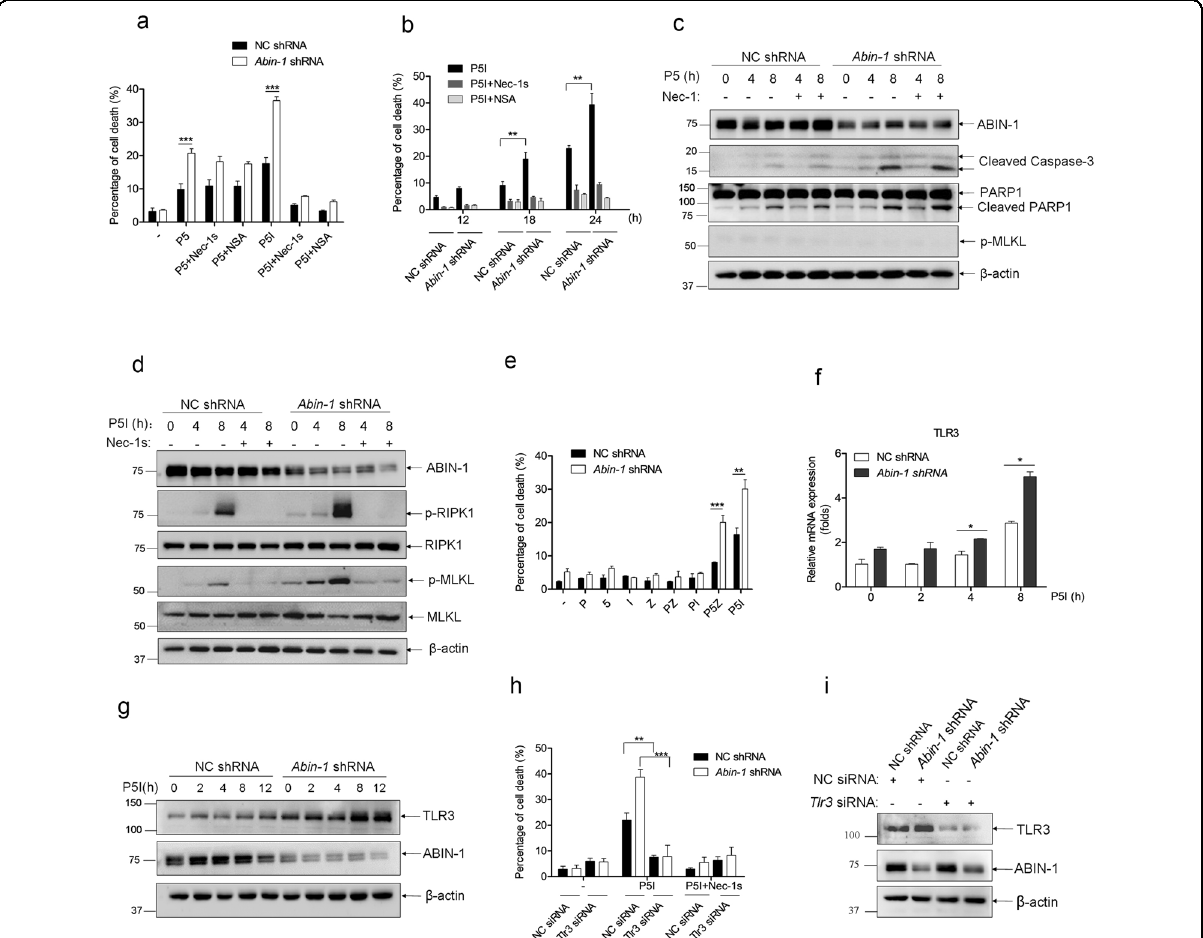
Fig. 2 ABIN-1 de fi ciency sensitizes colorectal cancer cells to poly(I:C)-induced cell death. a COLO205 cells were transduced with lentivirus- based control shRNA or Abin-1 shRNA and screened with puromycin for 5 days. Then, cells were treated with poly(I:C) + 5Z-7-oxozeaenol (P5) or poly (I:C) + 5Z-7-oxozeaenol + IDN-6556 (P5I) with or without Nec-1s or necrosulfonamide (NSA) for 24 h, and cell deaths were measured by ToxiLight assay. b Time course of P5I-induced cell death. NC shRNA and Abin-1 shRNA COLO205 cells were treated with P5I for 12, 18, or 24 h with or without Nec-1s or NSA. c COLO205 NC shRNA and Abin-1 shRNA cells were treated with P5 for 4 h or 8 h with or without Nec-1s, and then cells were lysed at indicated time points, followed by western blot analysis of ABIN-1 and apoptosis markers cleaved caspase-3 and PARP-1 and necroptosis marker p-MLKL. d COLO205 NC shRNA and Abin-1 shRNA cells were treated with P5I for 4 h or 8 h with or without Nec-1s, and then cells were lysed at indicated time points, followed by western blot analysis of ABIN-1, RIPK1, MLKL, and necroptosis markers p-RIPK1 and p-MLKL. e Comparison of poly(I: C) (P)-, 5Z-7-oxozeaenol 5 -, IDN-6556 (I)-, zVAD (Z)-, poly(I:C) + zVAD (PZ)-, poly(I:C) + IDN-6556 (PI)-, poly(I:C) + 5Z-7 + zVAD (P5Z)-, and P5I-induced cell deaths. Drug treatments for 24 h. f COLO205 NC shRNA and Abin-1 shRNA cells were treated with P5I for 0 – 8 h, and the total RNA was extracted and subjected to the qPCR assay of TLR3 expression. g COLO205 NC shRNA and Abin-1 shRNA cells were treated with P5I for 0 – 12 h, and cells were lysed and subjected to western blot analysis of ABIN-1 and TLR3. h , i COLO205 NC shRNA and Abin-1 shRNA cells were transfected with NC siRNA or Tlr3 siRNA and incubated for 24 h, followed by P5I treatment for another 24 h in the presence or absence of Nec-1s. Cell deaths were detected by ToxiLight assay ( h ), and knockdown ef fi ciency of TLR3 and ABIN-1 were analyzed by western blot ( i ). Poly(I:C), 10 μ g/ml; 5Z-7, 0.5 μ M;